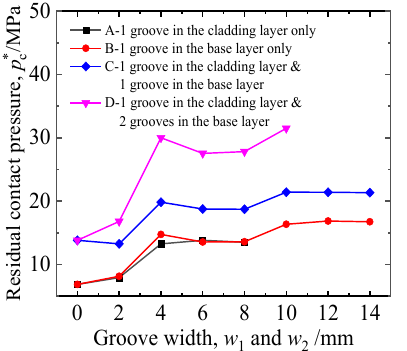
Figure 14. Effects of groove width on residual contact pressure.